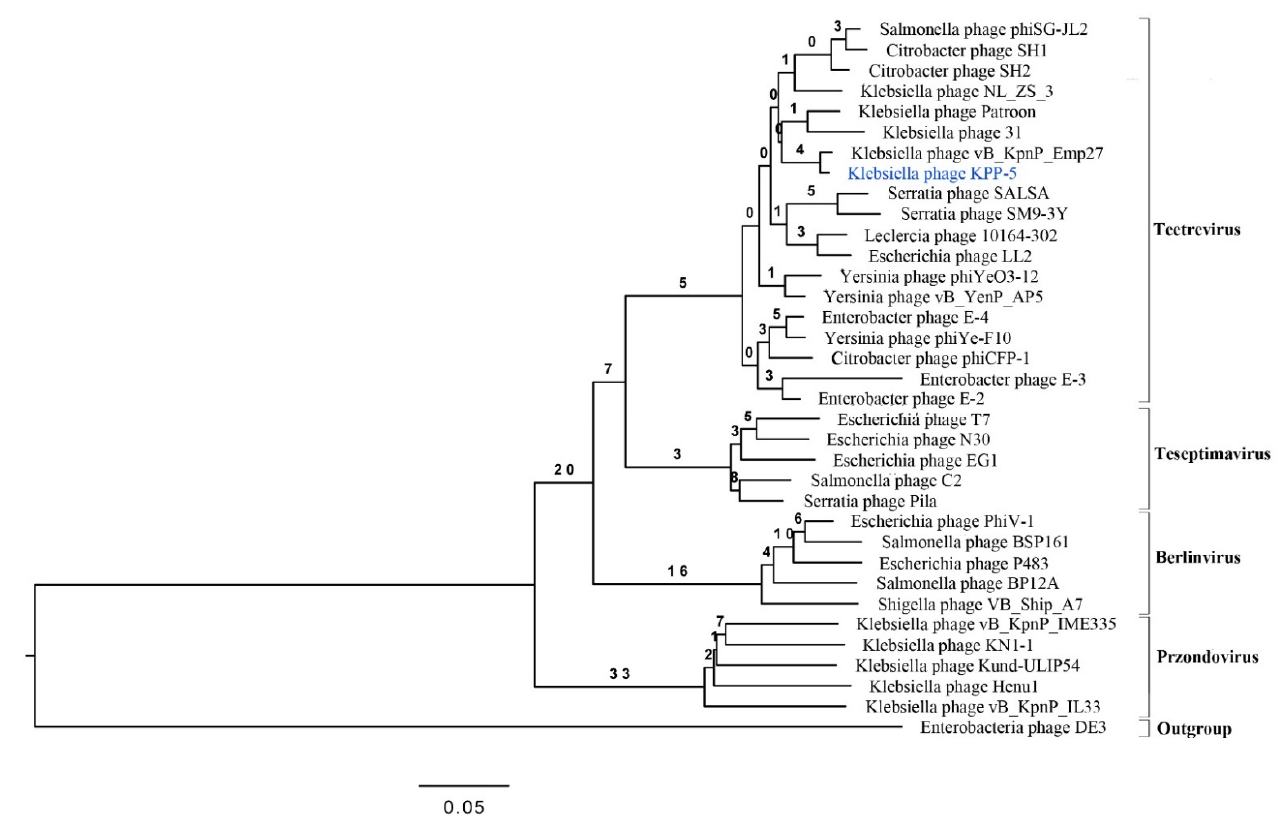
Figure 5. Phylogenetic relations of Klebsiella phage KPP-5 based on the whole genome sequence generated by VICTOR.